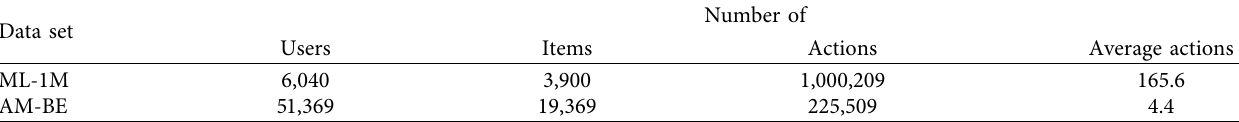
A LGORITHM 1: The sequential recommendation algorithm proposed in this paper. Table 1: The information of the two data